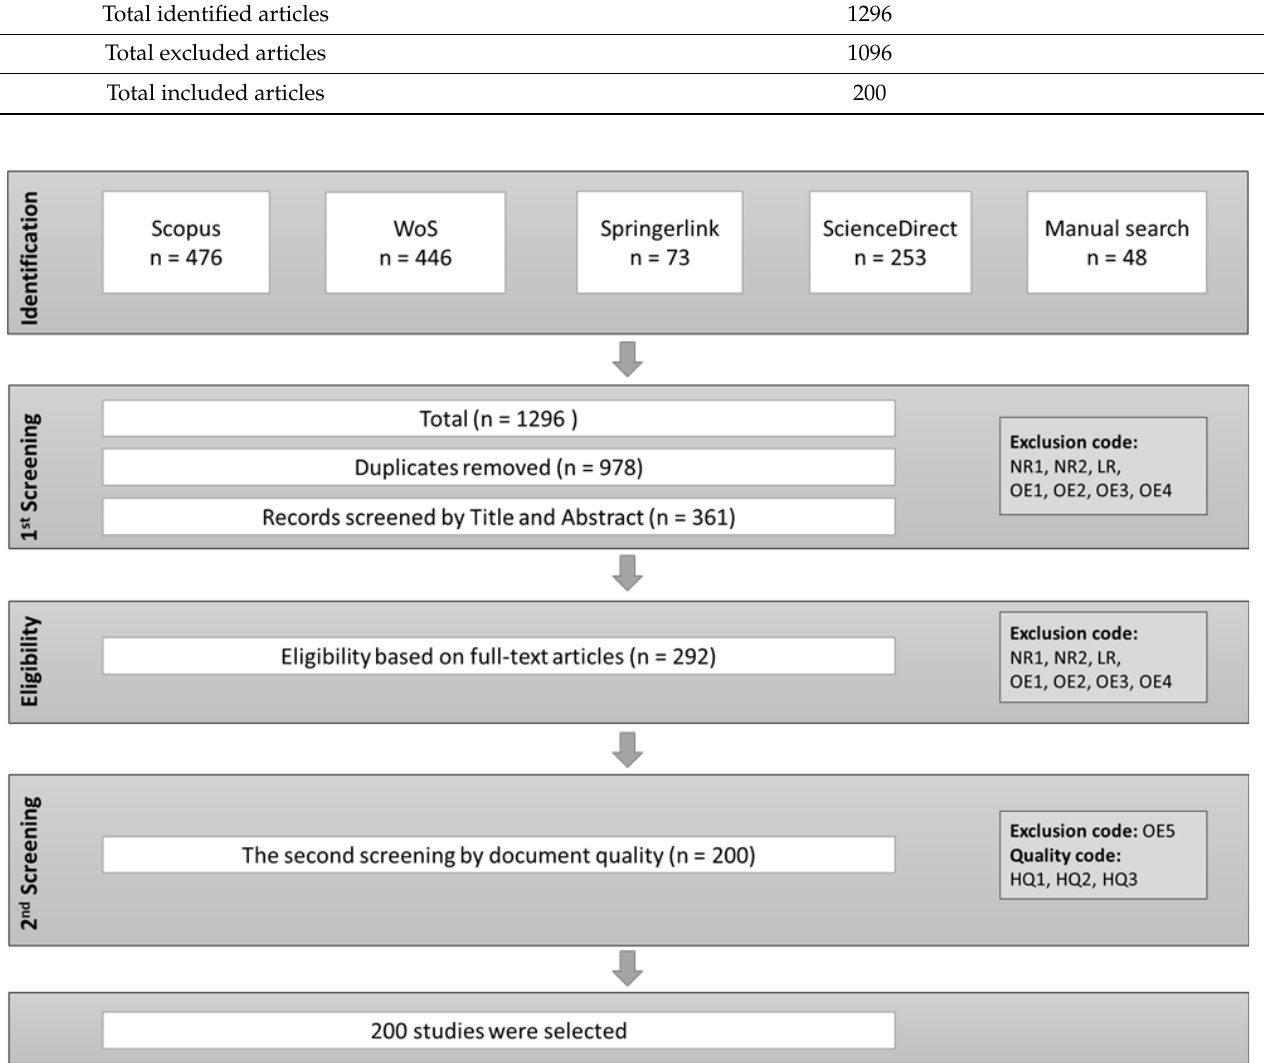
Table 4. Selection criteria.